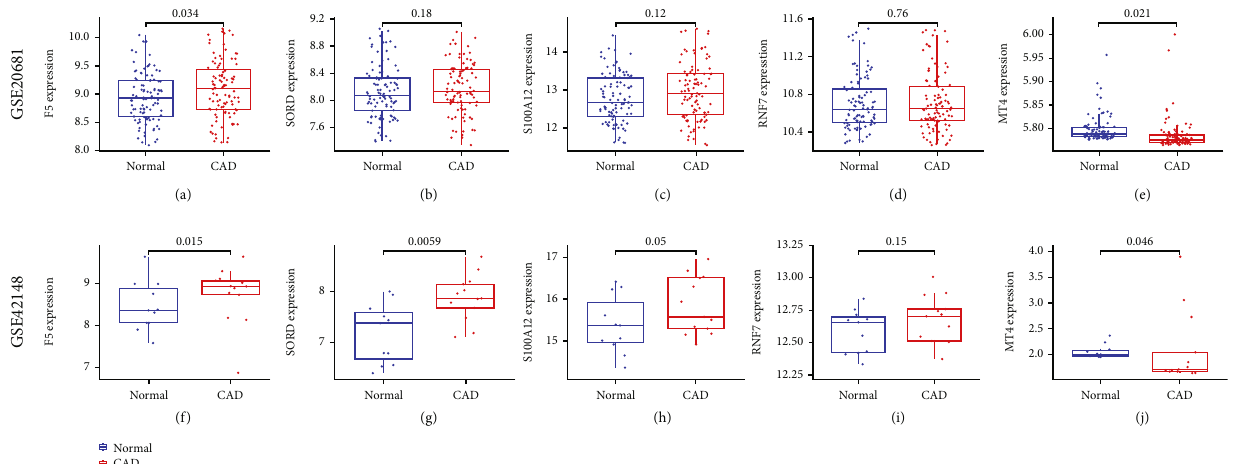
Figure 8: Validated the expression levels of the 5 marker genes in two testing sets. (a – e) Di ff erential expression analyses of F5, SORD, S100A12, RNF7, and MT4 between CAD samples and healthy controls in the GSE20681 dataset. (f – j) Di ff erential expression analyses of F5, SORD, S100A12, RNF7, and MT4 between CAD samples and healthy controls in the GSE42148 dataset.